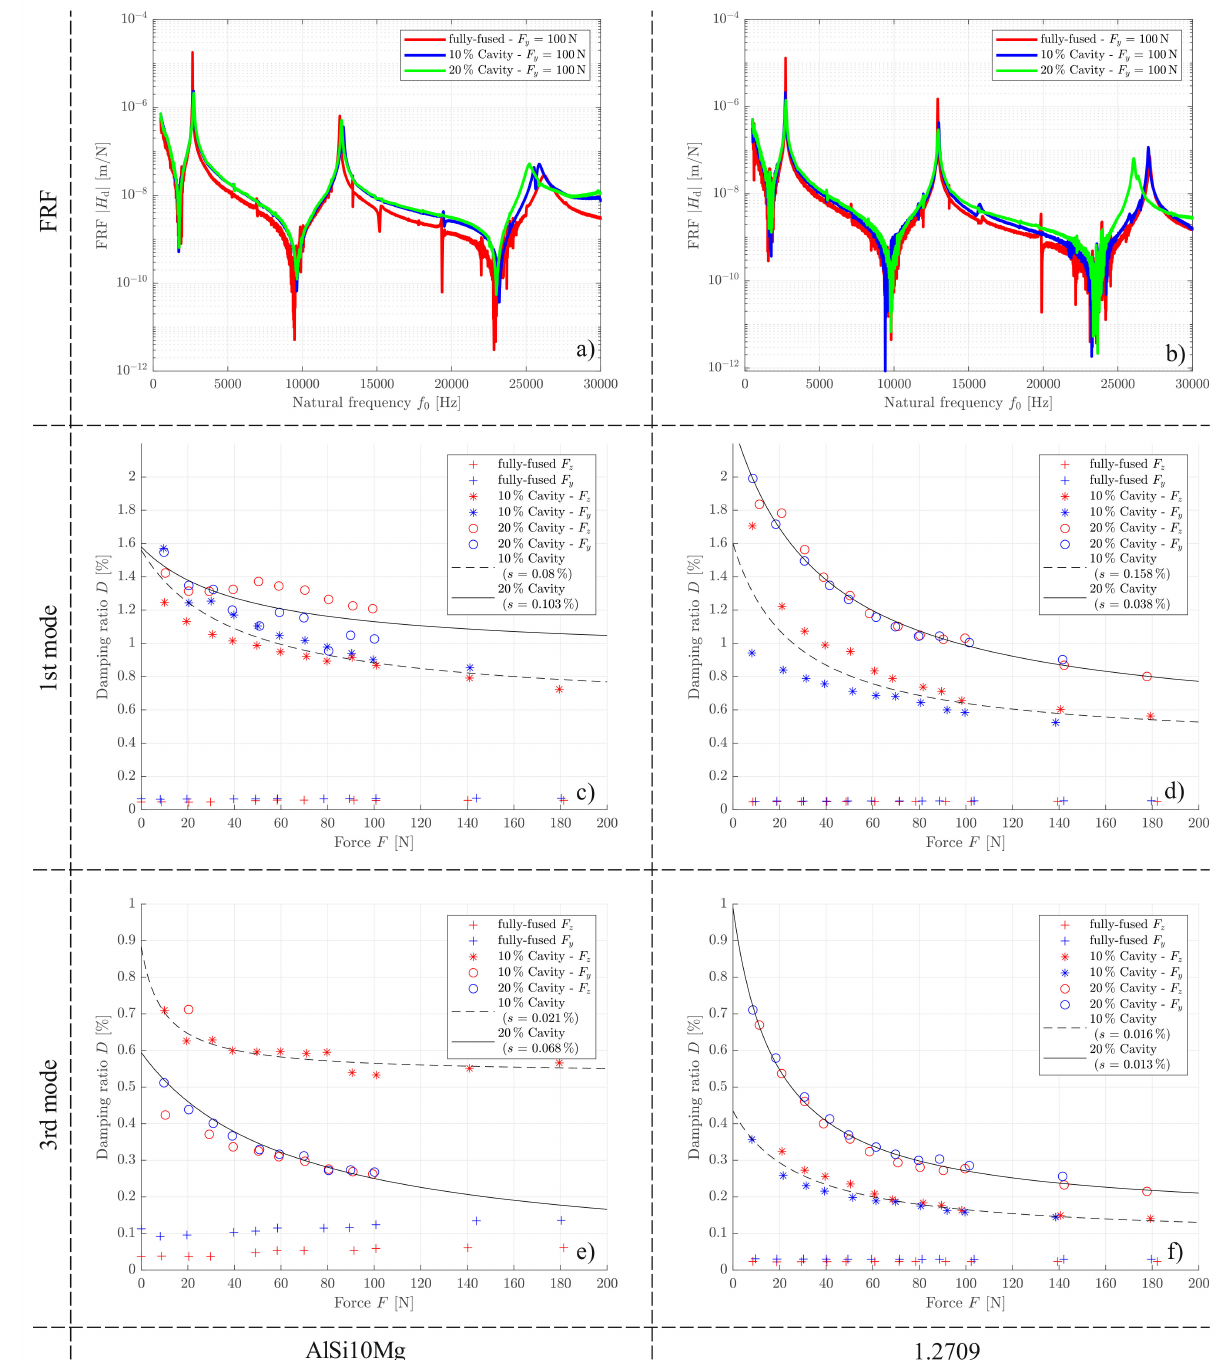
Figure 12. Frequency response functions and force-dependent damping characteristics (1st and 3rd mode) Left: outer dimensions: 20 × 20 × 200 mm 3 , parameter 1, 23 and 25, material: AlSi10Mg, right: outer dimensions: 16.9 × 16.9 × 169 mm 3 , parameter 40–42, material: